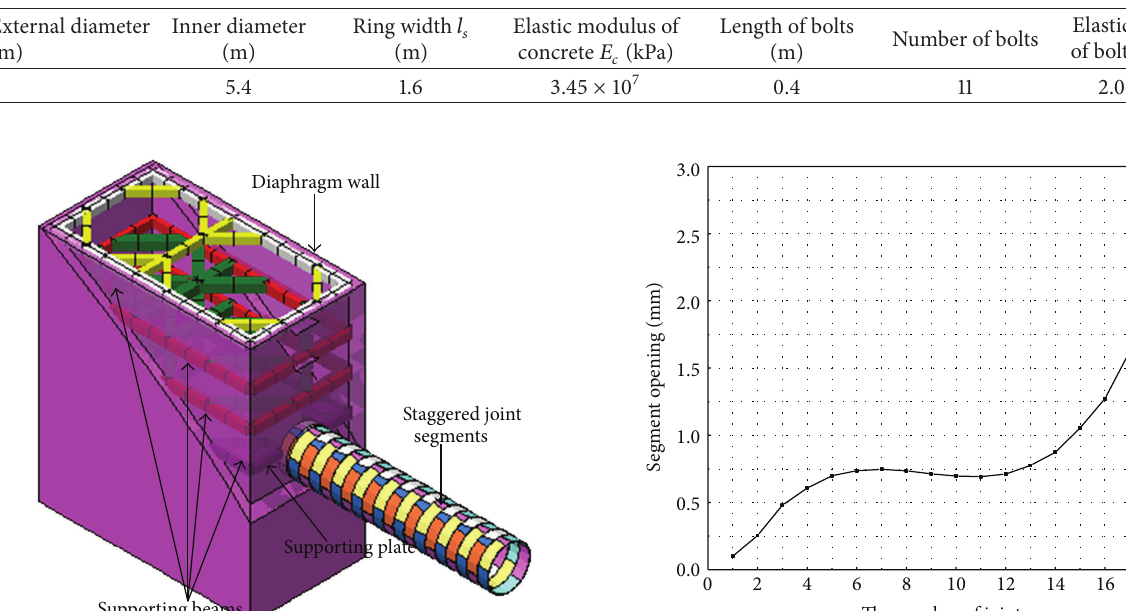
Table 3: Structural parameters of lining segments.